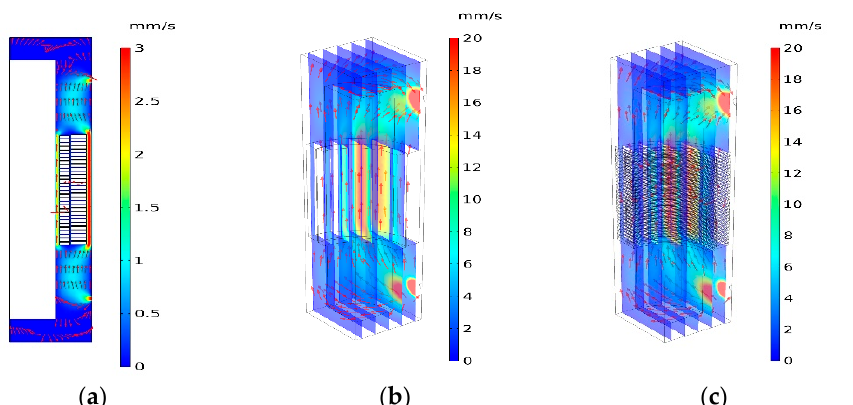
Figure 6. Fluid field distribution of the transformer. ( a ) Distribution diagram of two-dimensional flow field; ( b ) distribution diagram of three-dimensional flow field; ( c ) distribution diagram of the improved three-dimensional flow field.